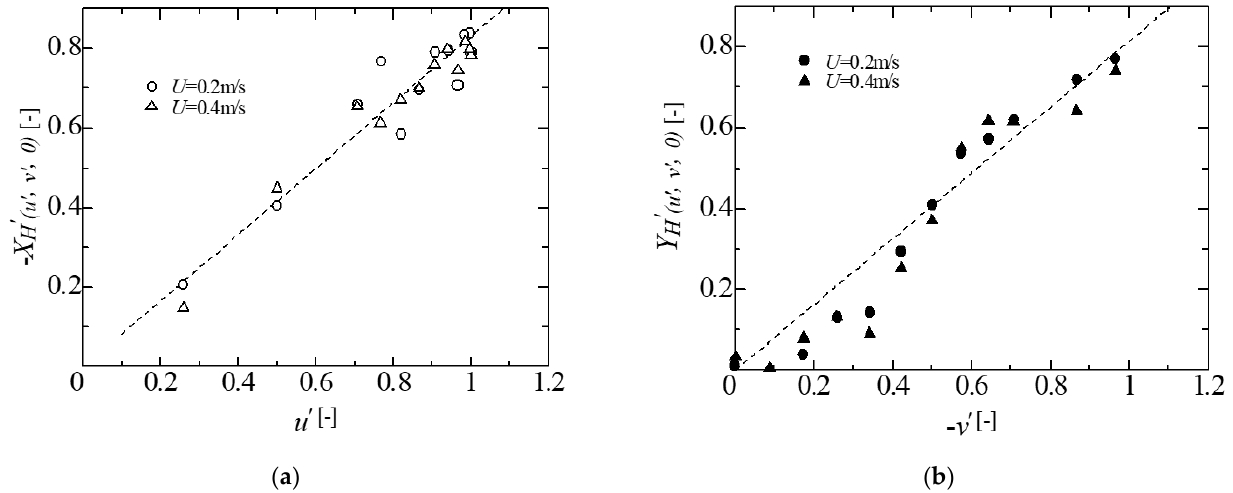
Figure 9. ( a ) Variation of the dimensionless fluid force along the x -axis with u ′ ; ( b ) Variation of the dimensionless fluid force along the y -axis with v ′ .